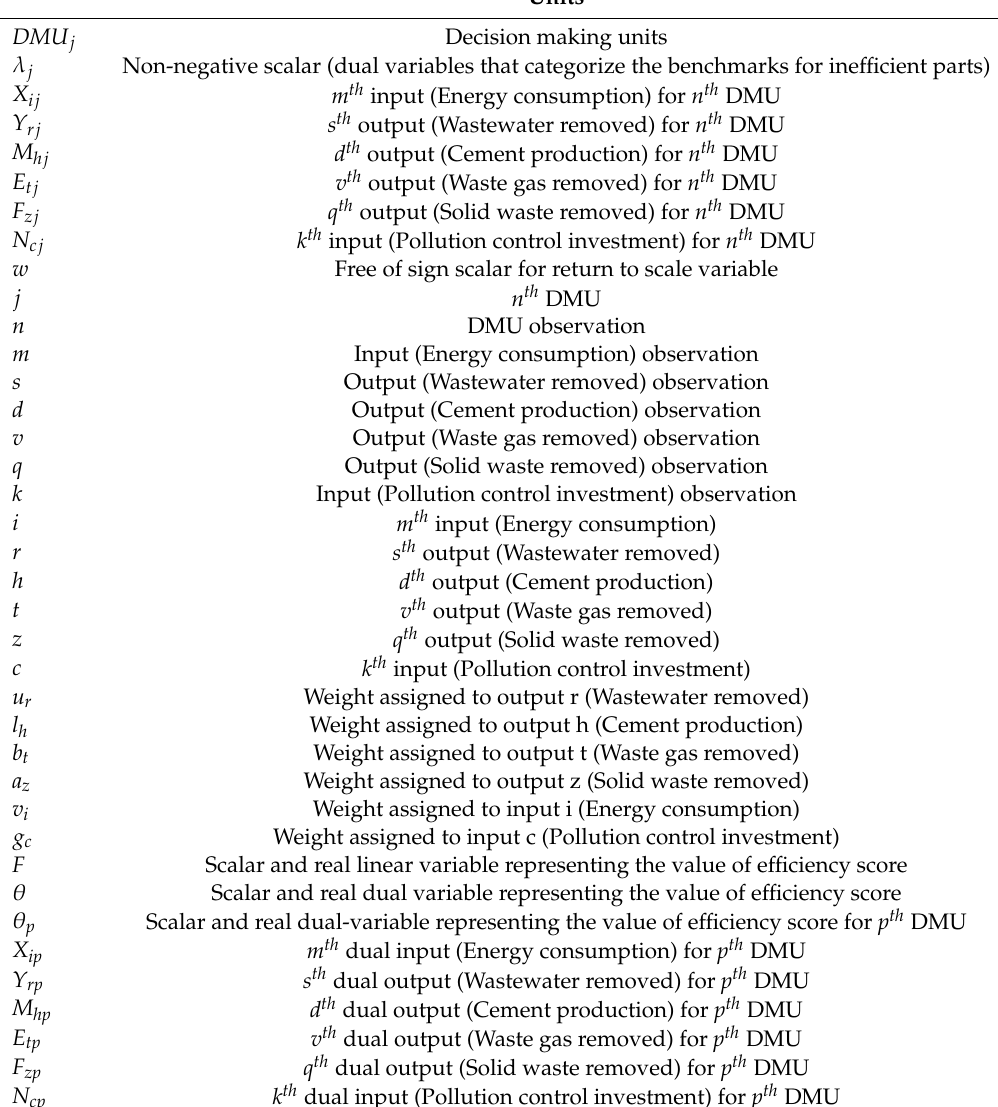
Table 3. Explanation of dimensionless parameters in nomenclature for primal and dual proposed